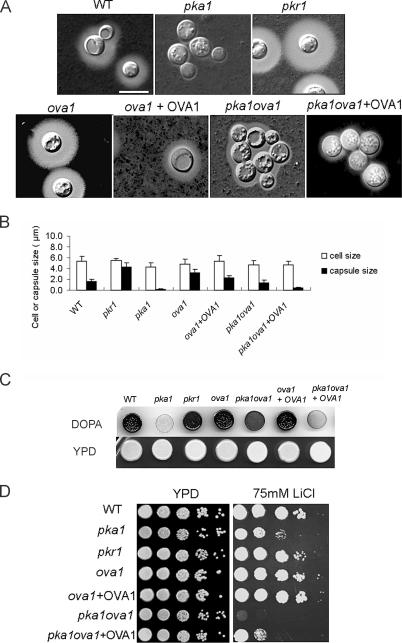
Influence of the ova1 Mutation on Capsule and Melanin Formation, and Epistasis with pka1
(A) Capsule size is shown by staining with India ink for the WT and mutant strains. Cells were cultured either in liquid LIM or on DMEM plates (for capsule induction) at 30 °C. The photographs are of cells cultured for 48 h in LIM, and the same results were obtained in several independent trials. Bar = 10 μM.(B) Sixty cells from the cultures used for (A) were measured for cell diameter and capsule radius. Each bar represents the average of 60 measurements. The capsule sizes were statistically different (p <0.001) for all pair-wise comparisons except WT versus pka1ova1, and pka1 versus pka1ova1+OVA1.
(C) Melanin formation was tested in the strains indicated by inoculation of cultures on L-DOPA or YPD plates (as a control to demonstrate equal growth) and incubation for 2 d at 30 °C.(D) Sensitivity of the pka1 mutant and the pka1 ova1 double mutant to LiCl. Cells were washed and 10-fold serial dilutions of a 106 cells/ml suspension were plated on either YPD or YPD + 75 mM LiCl.